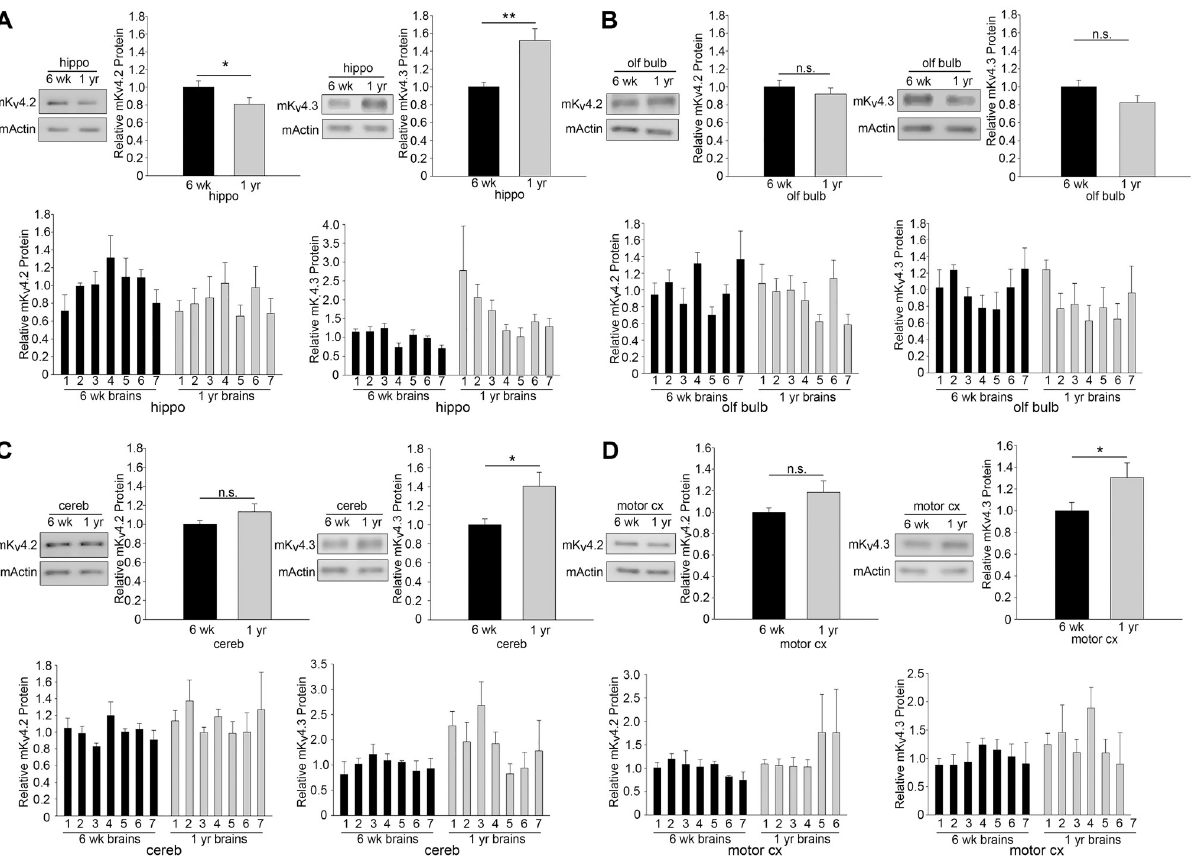
Fig 6. Differential effects of age on mouse K v 4.2 and K v 4.3 in various brain regions. Representative immunoblots and quantitative analysis, as described in the text, for K v 4.2 and K v 4.3 protein in tissue homogenates from seven 6-wk old mice and seven 13-month old mice; tissue homogenates are from the (A) hippocampus (hippo), (B) olfactory bulb (olf bulb), (C) cerebellum (cereb), and (D) motor cortex (motor cx). Black bars represent 6-week (6wk) old mice and grey bars represent 13-month (1yr) old mice. 15 μ g total protein per sample was loaded into each SDS-PAGE well (N = 35 samples, across 5 blots, for each brain at each age). Top graphs , shown are mean values +/- SEM across 7 brains; Bottom graphs , shown are mean values +/- SEM from individual brains; � p < 0.05, �� p � 0.01, Linear Mixed Model statistical analysis (see Materials and methods).